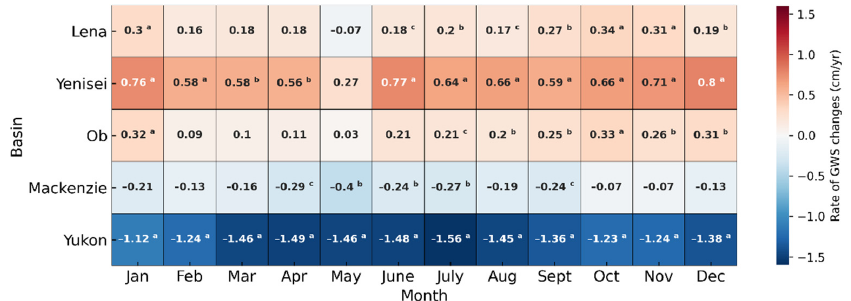
Figure 4. Trends in GWSA (cm/year) in different months over 2002–2017. The horizontal axis refers to months and vertical axis refers to the five basins. The value in each square of a panel refers to the rate of GWS change in a specific month over the 15-year period. The p -values were calculated using the Wald Test with a t-distribution of the test statistic. “ a ” refers to a p -value ≤ 0.01, “ b ” refers to 0.01 < p -value ≤ 0.05, and “ c ” refers to 0.05 < p -value ≤ 0.10.